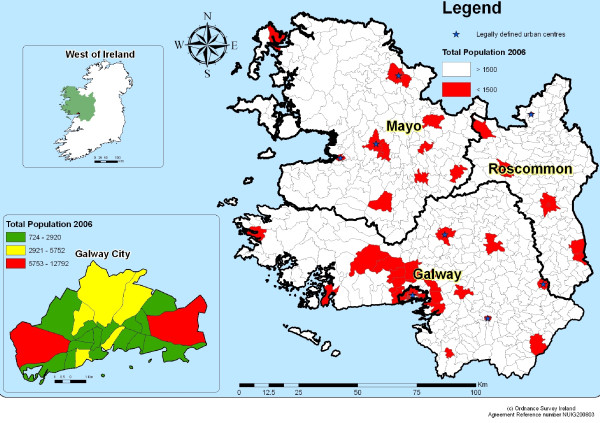
Urban Centres in the West of Ireland 2006.